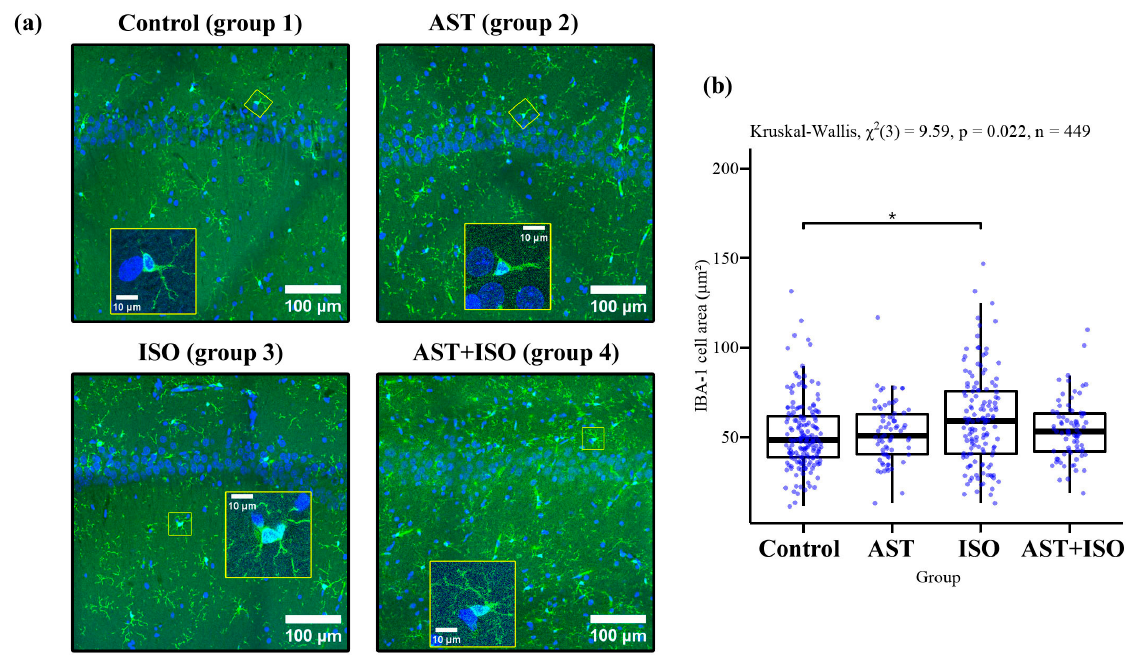
Figure 1. Iba-1 positive cells in the CA1 region of rat hippocampus at day three post-treatment. ( a ) Overview images of areas in CA1 region of hippocampus; ( b ) quantification of area of cell MIP in CA1 region. Statistical analysis was carried out using R v.4.0.4 and RStudio v.1.4.1106. Normality was tested using Shapiro–Wilk test. The α -value used was 0.05. Because of non-normal distribution and unequal sizes of groups in some of the comparisons, a non-parametric Kruskal–Wallis test was used with Dunn test for pairwise comparisons. The post-hoc tests were done using Bonferroni procedure.